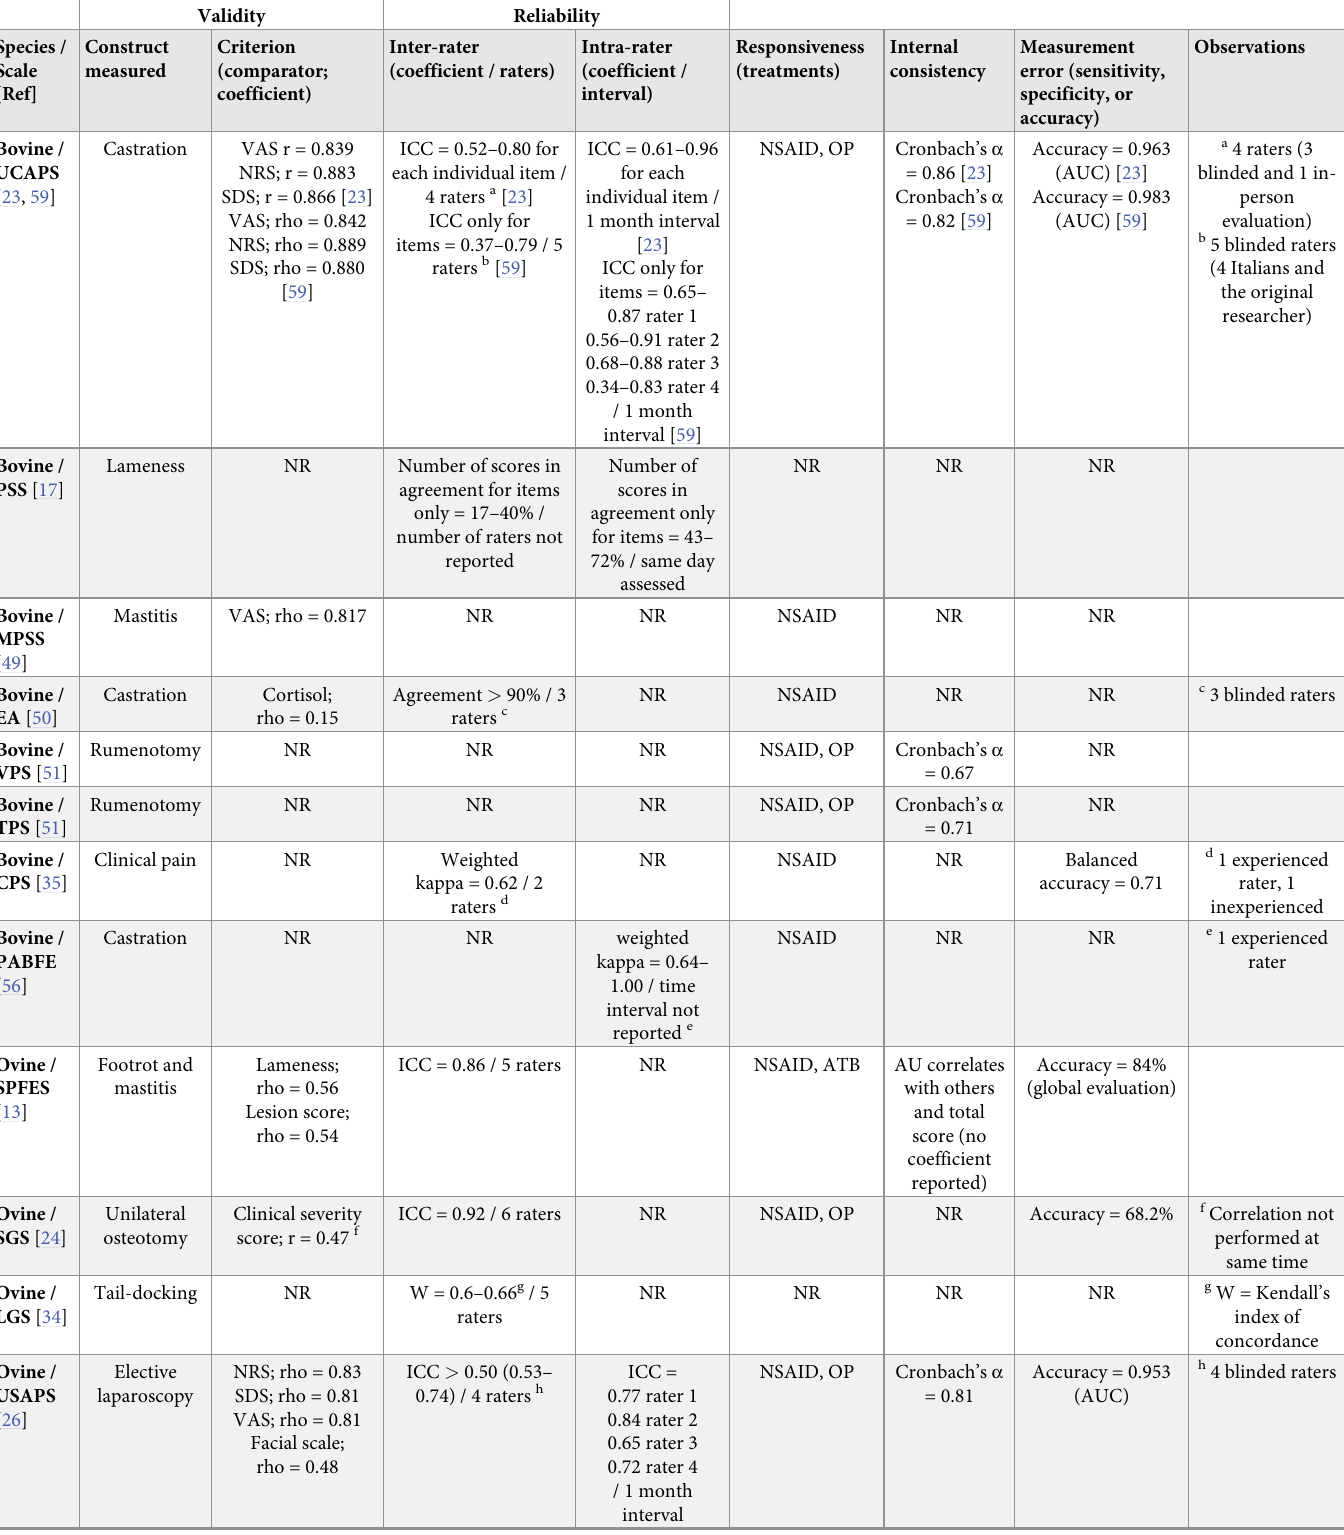
Table 6. Summary of the findings of measurement properties for each pain scoring instrument in farm animals included in the systematic